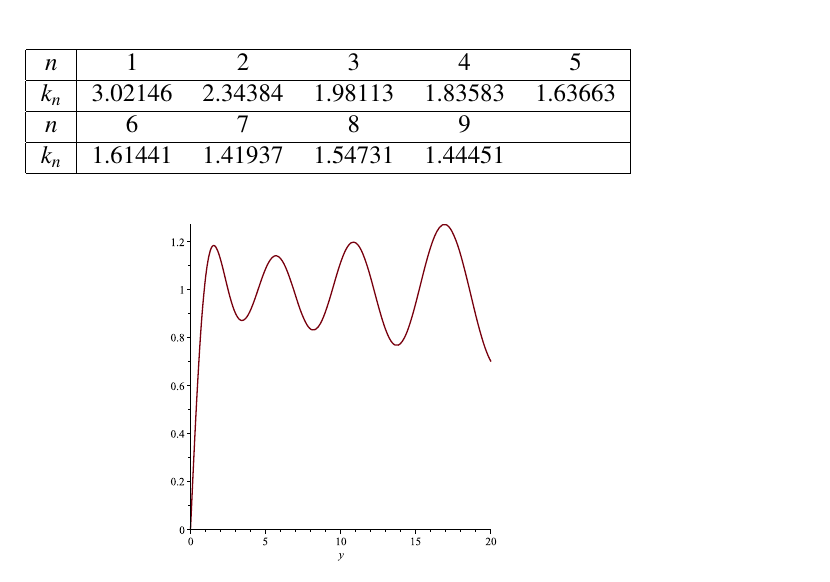
Figure 1. Approximation Φ l 9 (0 ,y ;1) to the function Φ (0 ,y ;1) in the interval [0 , 20] when the first 9 terms are used in the summation.